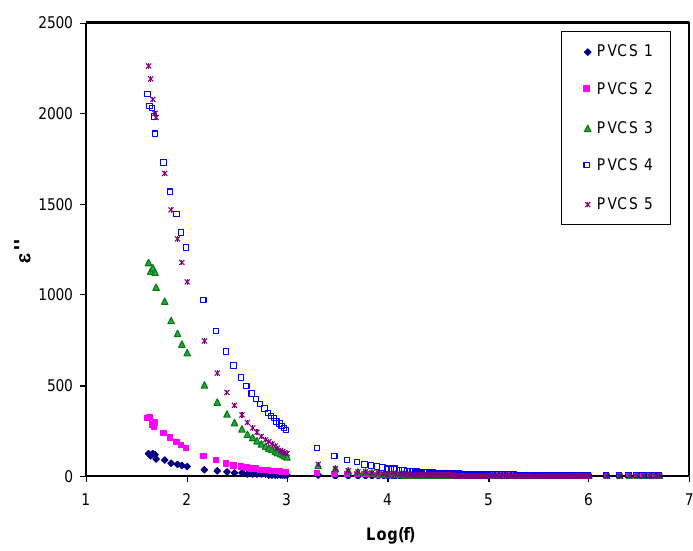
Figure 8. Dielectric constant versus log (f) for all polymer blend electrolytes.